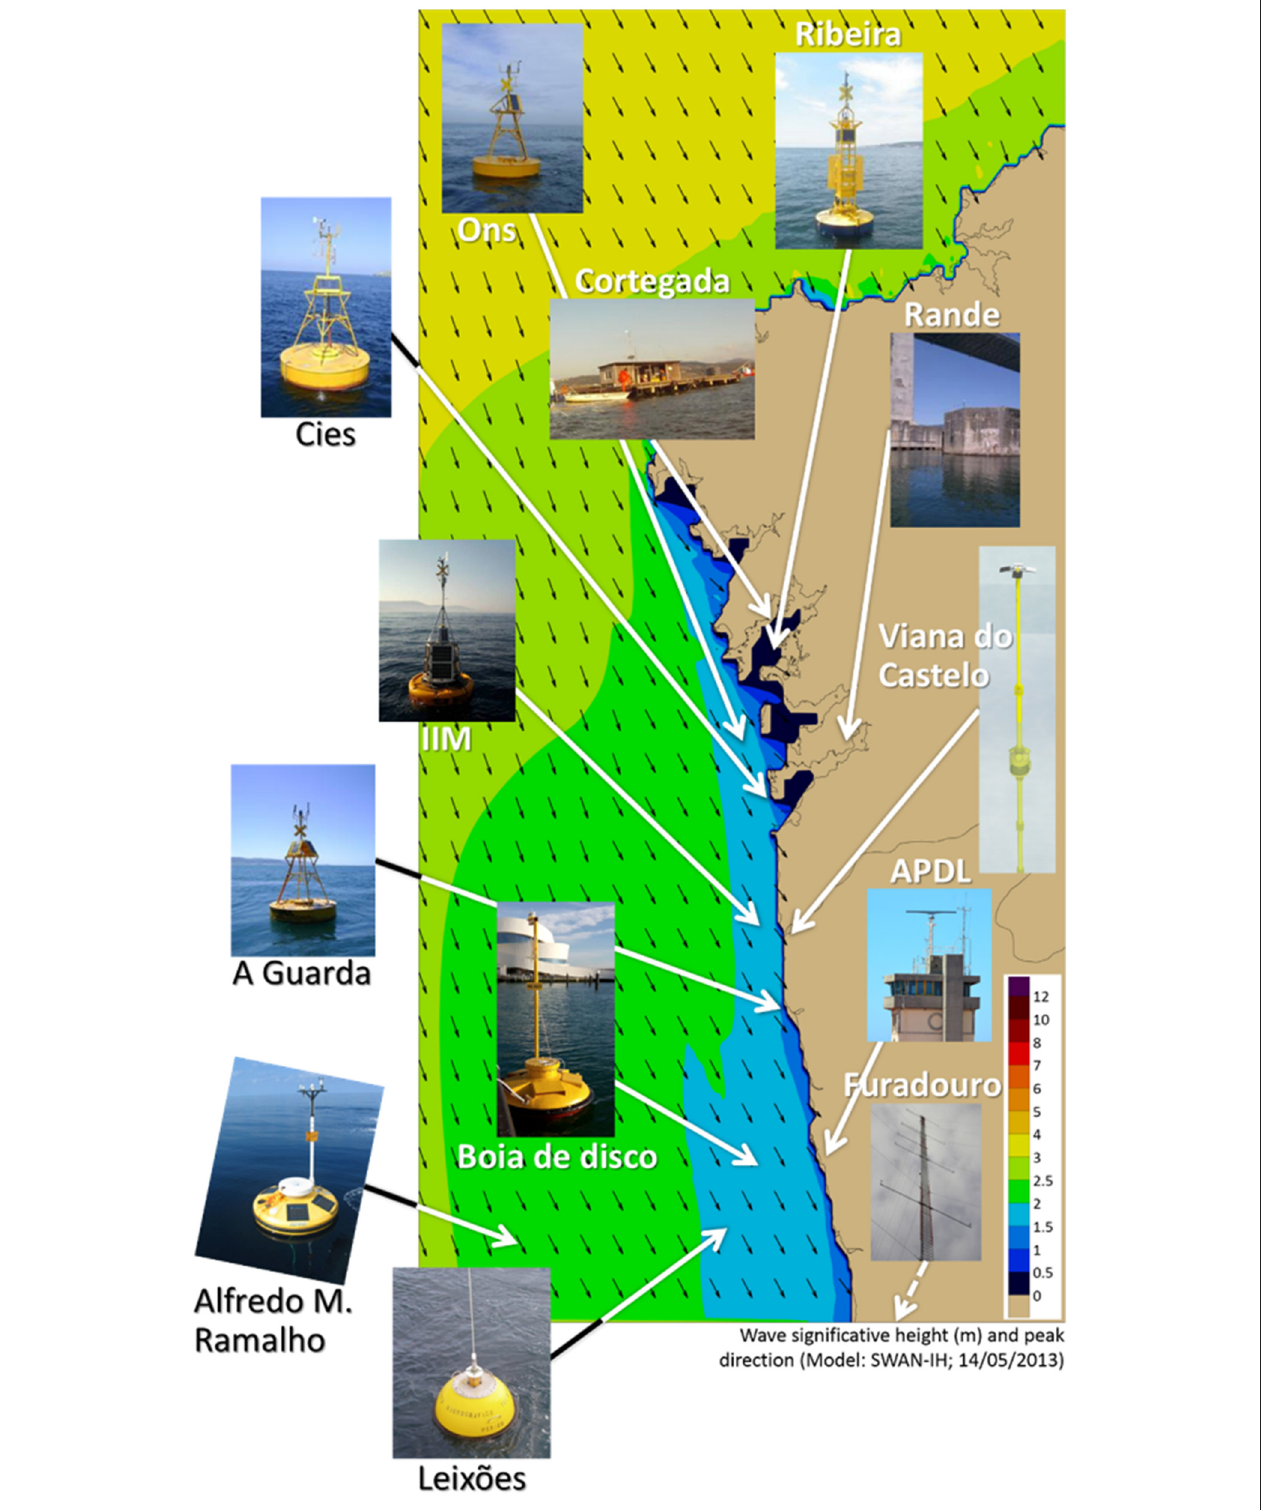
FIGURE 3 | RAIA Observatory monitoring